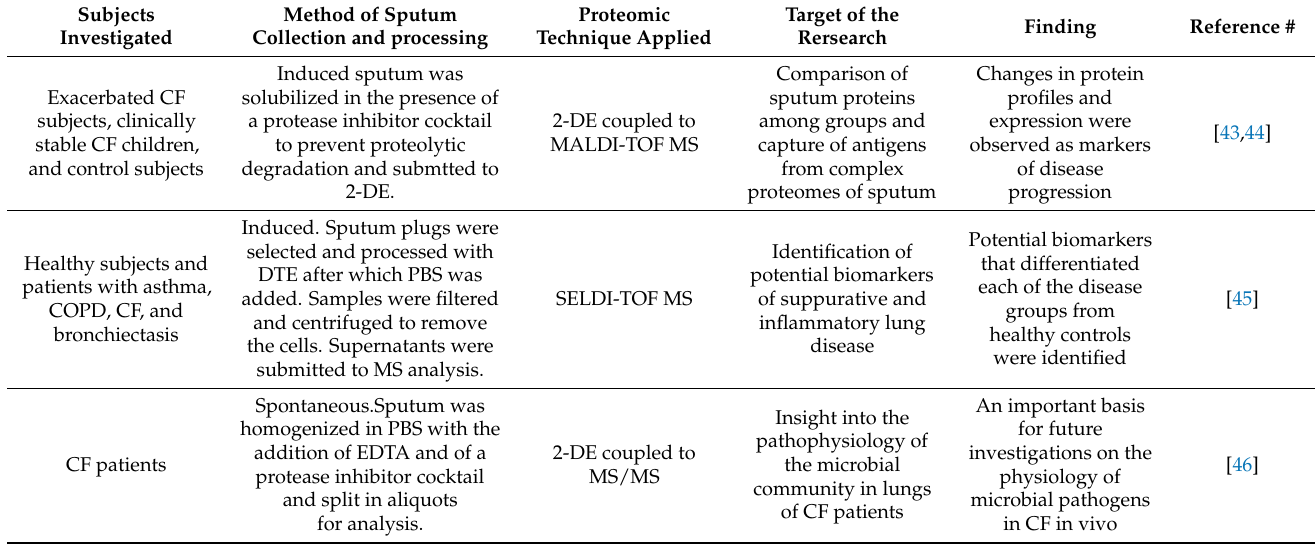
Table 4. List of articles dealing with proteomics of sputum in patients with cystic